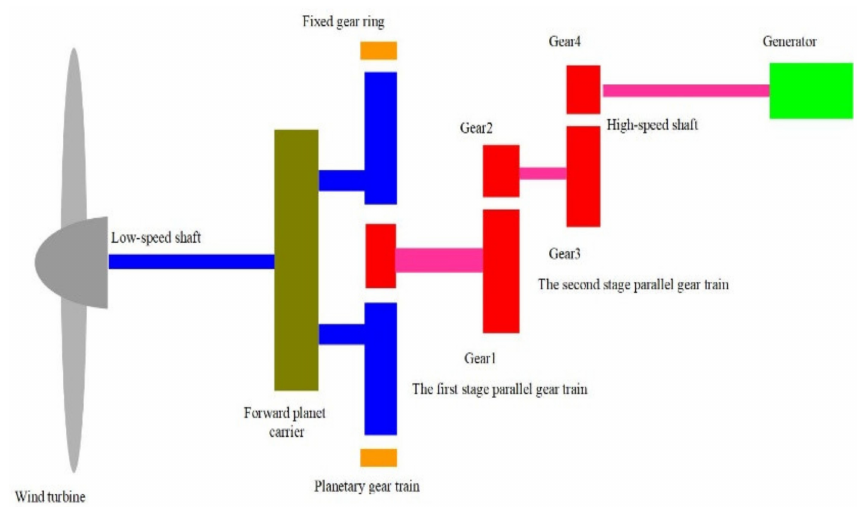
Figure 1. The structural diagram of the wind turbine drivetrain.